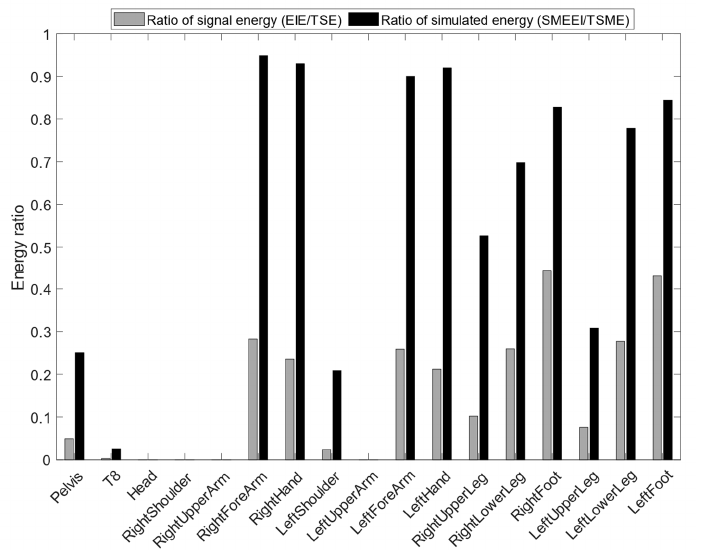
Figure 14. Ratios of energy from original data and extracted impacts only. The signal energy was obtained using the mathematical energy (Equation (12)), and the simulated energy was obtained using the harvester model simulation.